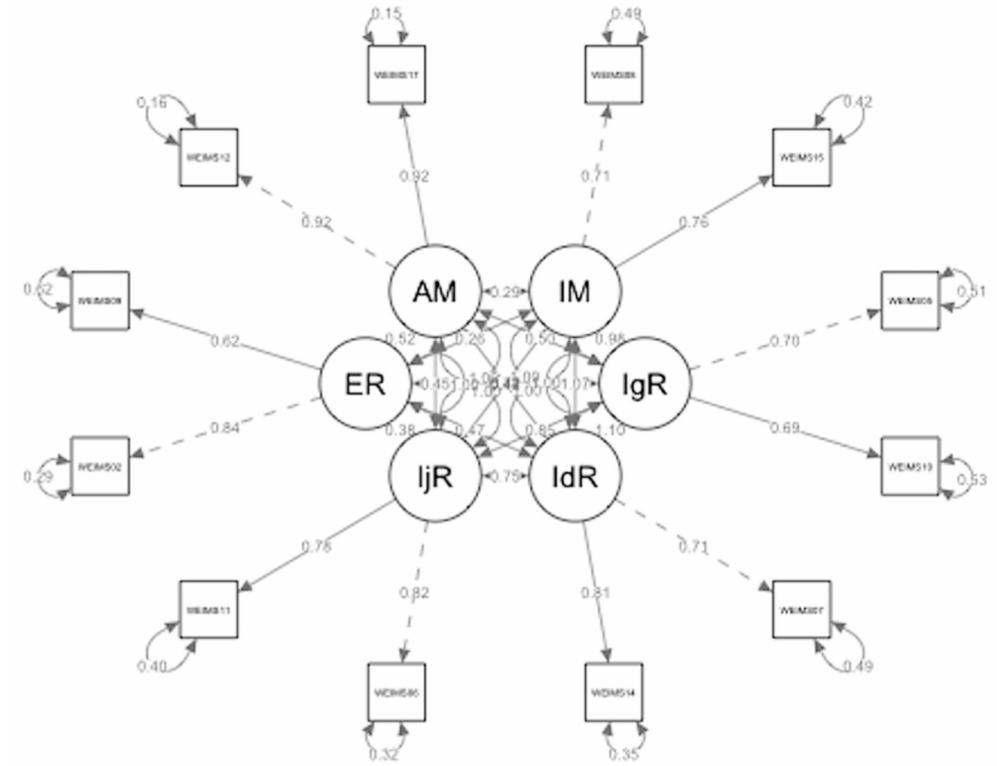
Figure 1. Factor structure of the six-factor model of the Short Work Extrinsic and Intrinsic Motivation Scale (SWEIMS). IM = Intrinsic Motivation; IgR = Integrated Regulation; IdR = Identified Regulation; IjR = Introjected Regulation; ER = External Regulation; AM =